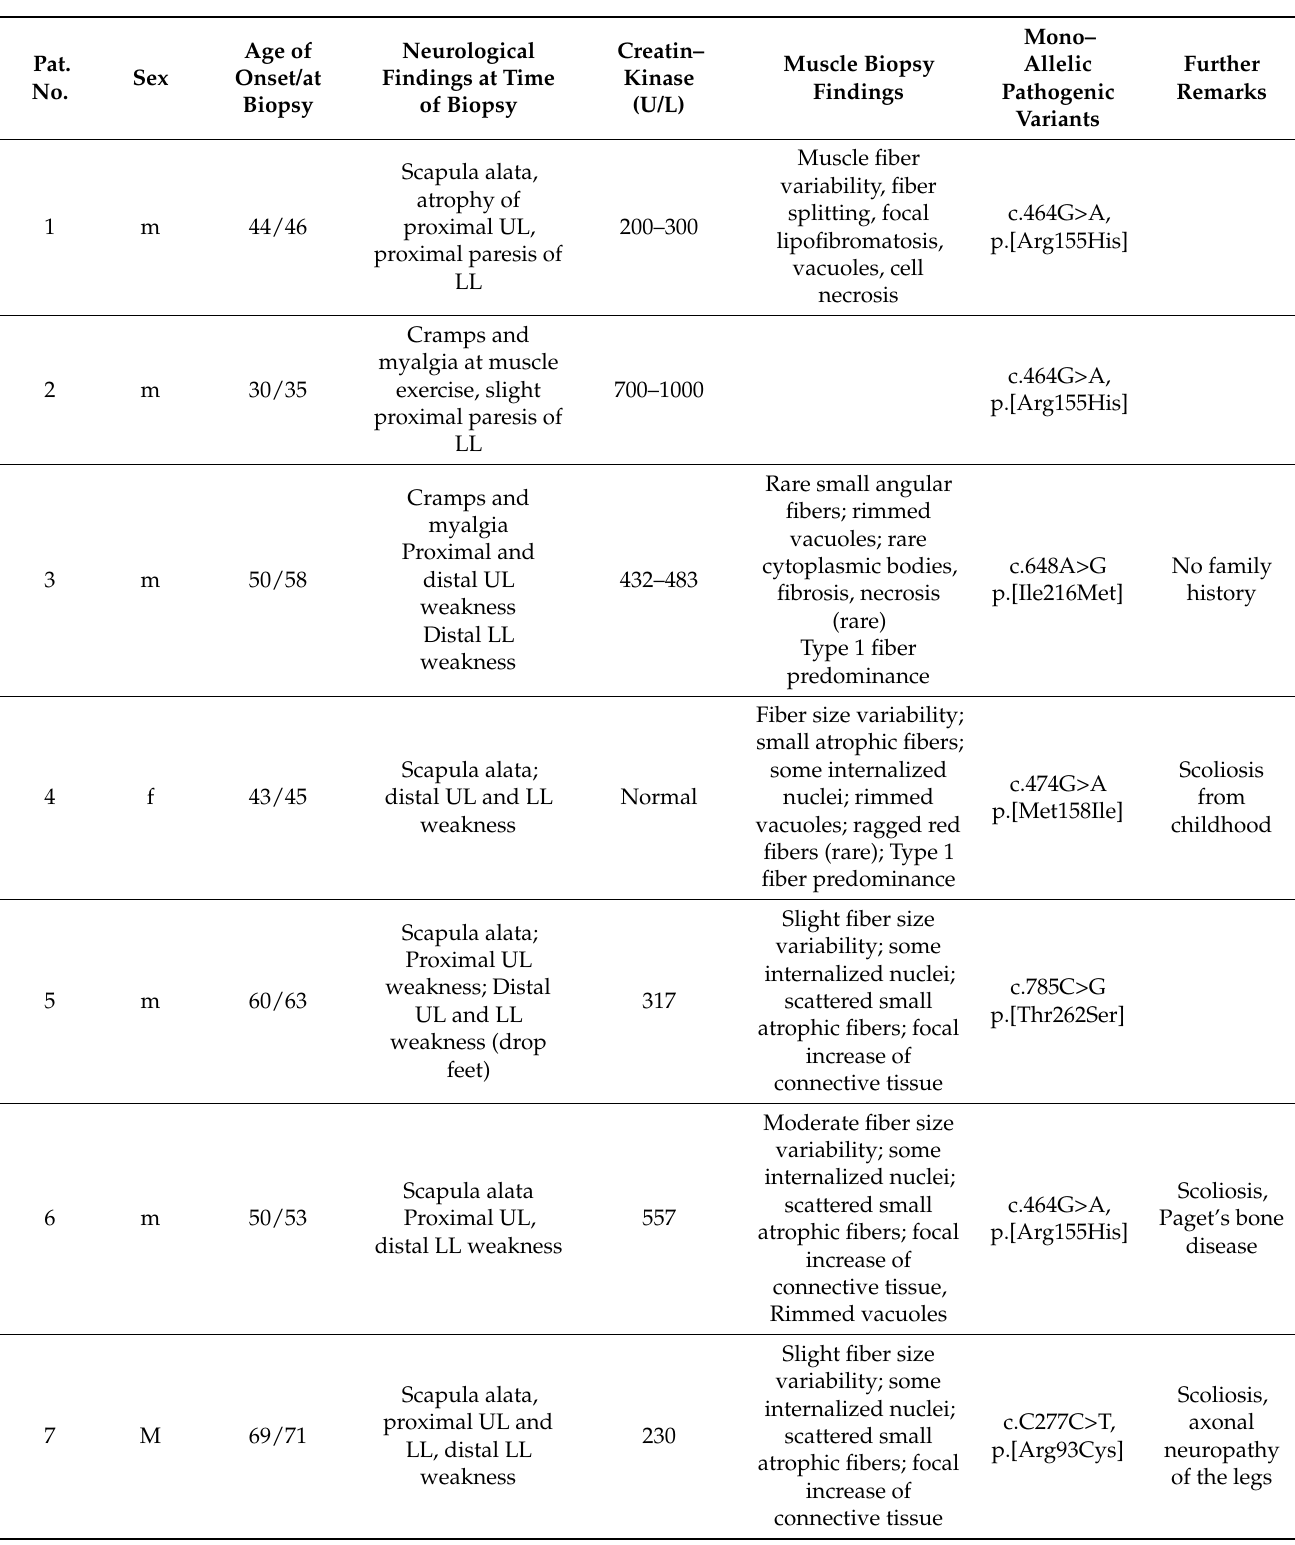
Table 1. Patient characteristics, muscle biopsy findings and pathogenic variants of patients for which muscle biopsies were included in the study. Pat. No.: patient number; UL: upper limbs, LL: lower